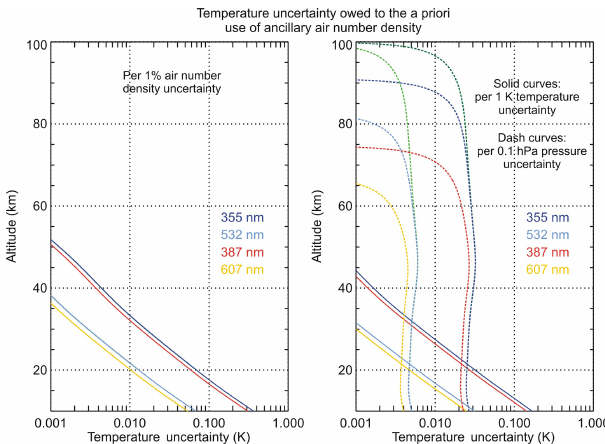
Figure 5. Temperature uncertainty owing to the a priori use of ancil- lary air number density in the molecular extinction correction. The results are shown per 1% ancillary number density uncertainty (left plot), and per 1K and 0.1hPa ancillary temperature and pressure uncertainty respectively (right